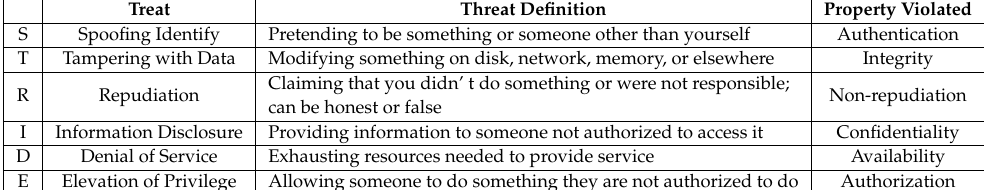
Table 3. STRIDE Threat Modeling [48].